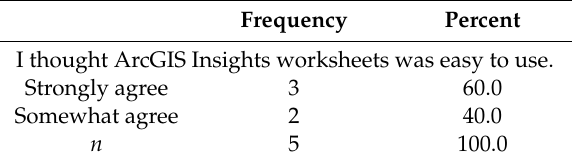
Table 5. Percentages and Frequencies, Q48.